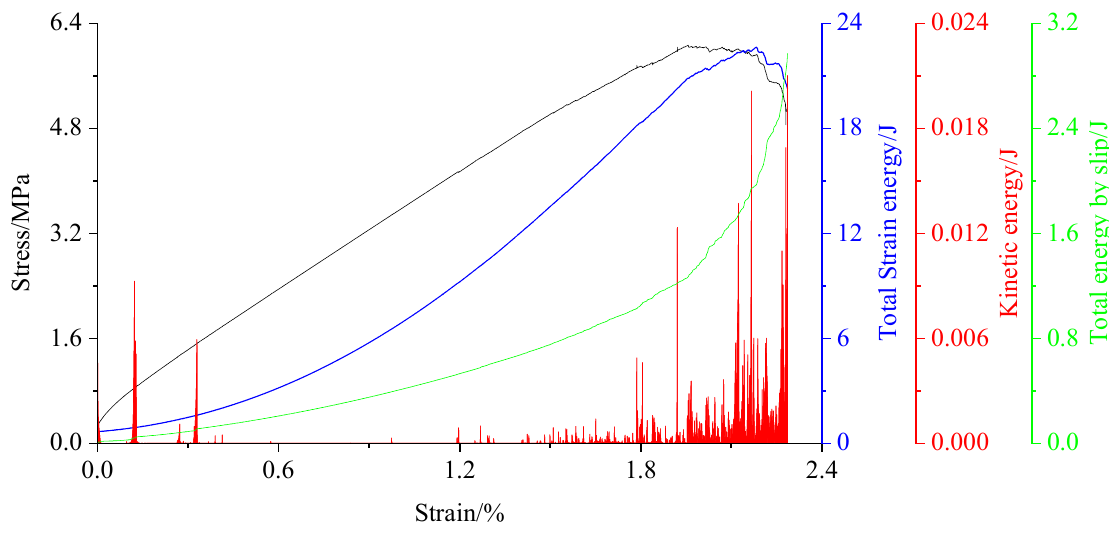
Figure 11. Various energy changes in coal failure process.